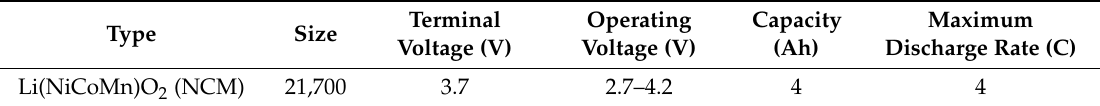
Figure 2. Battery test bench. Table 1. Battery specifications.